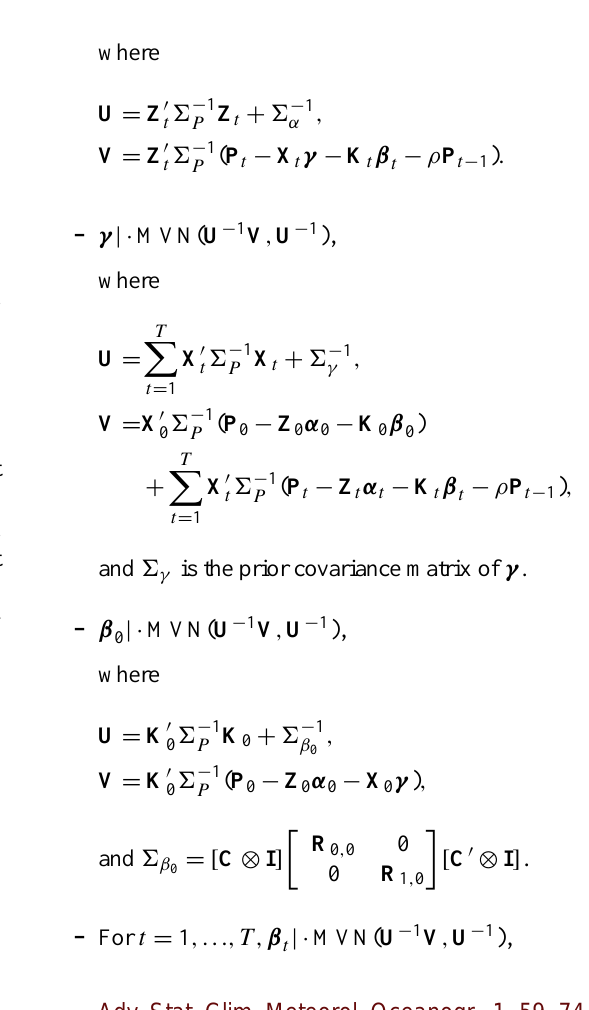
Figure A2. Normal Q–Q plots of the square root-transformed AOT on 4 consecutive